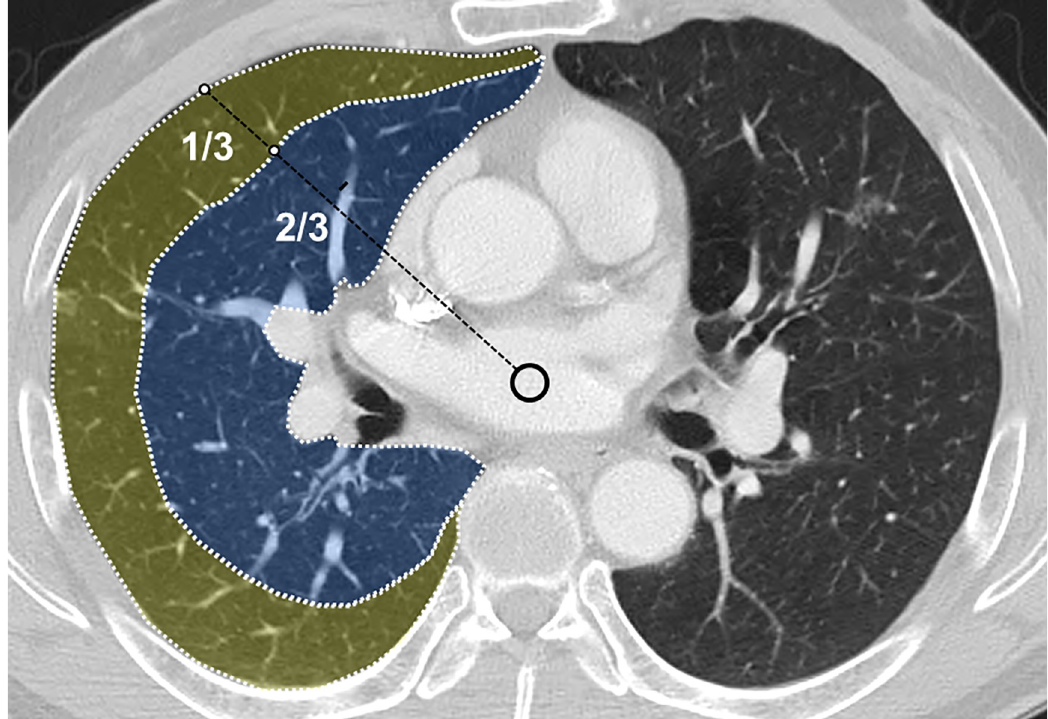
Fig 2. Diagram showing how tumor location was determined. The center (circle) of the tracheal lumen or imaginary downward extension of the trachea was determined at the level of the tumor’s maximum diameter on the axial scan. Then an imaginary border separating the peripheral one-third and central two-thirds was drawn. This border represented the boundary dividing peripheral and central tumors.